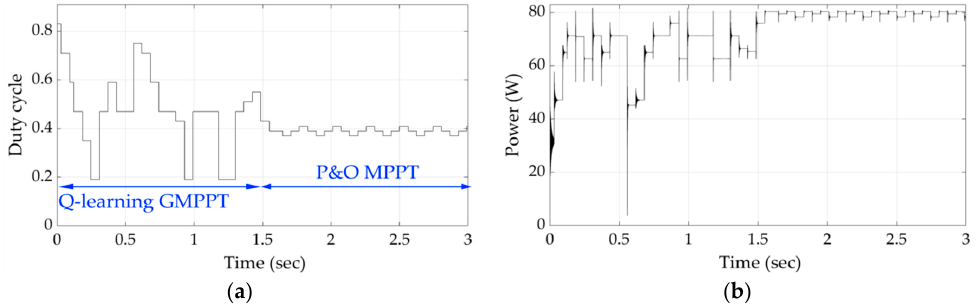
Figure 13. Results during execution of the proposed Q-learning-based GMPPT process for shading pattern 6: ( a ) duty cycle versus time and ( b ) PV array output power versus time.